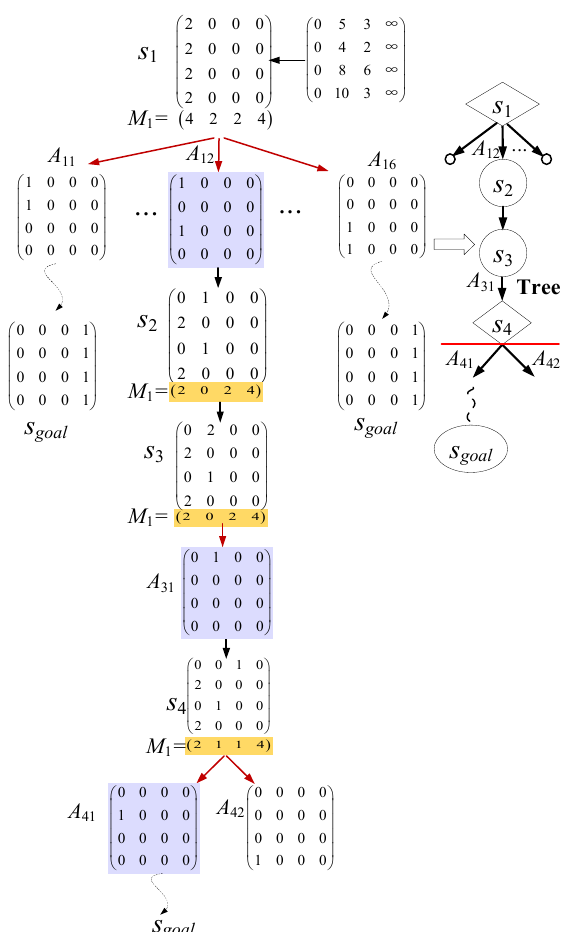
Figure 1. Schematic of the hybrid flow shop scheduling problem (HFSSP) state evolution.